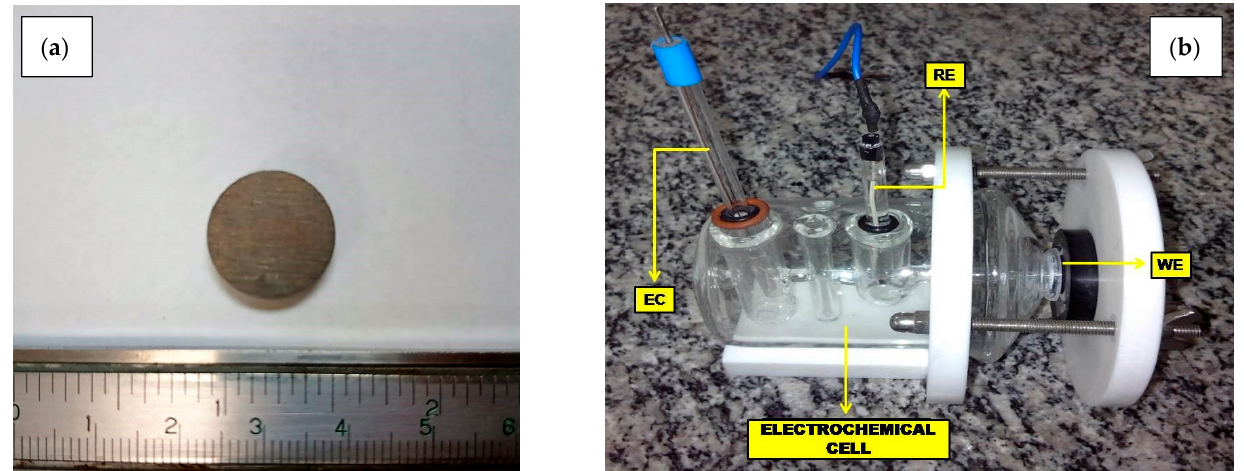
Figure 1. (a) Specimen of AA2524 in as-received condition and ( b ) three-electrode setup configuration cell. The reference electrode (RE) was an Ag/AgCl, 3 mol L − 1 KCl, and a platinum wire was employed as an auxiliary electrode (EC). The sample was the working electrode (WE).